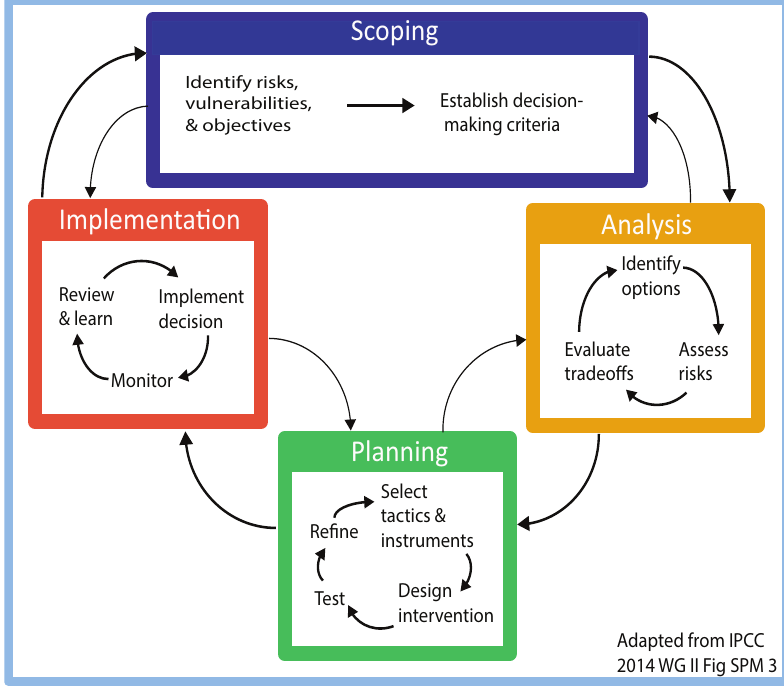
Figure 1. Extended adaptation process model. This extended model includes a phase for planning between analysis and